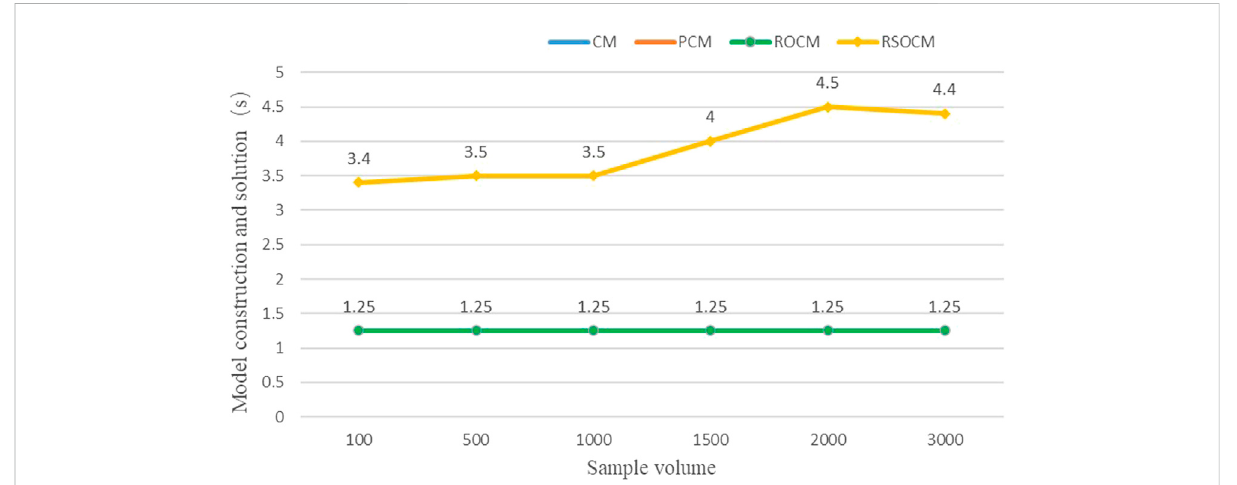
FIGURE 4 Comparison of calculation time of different models under different sample volumes.